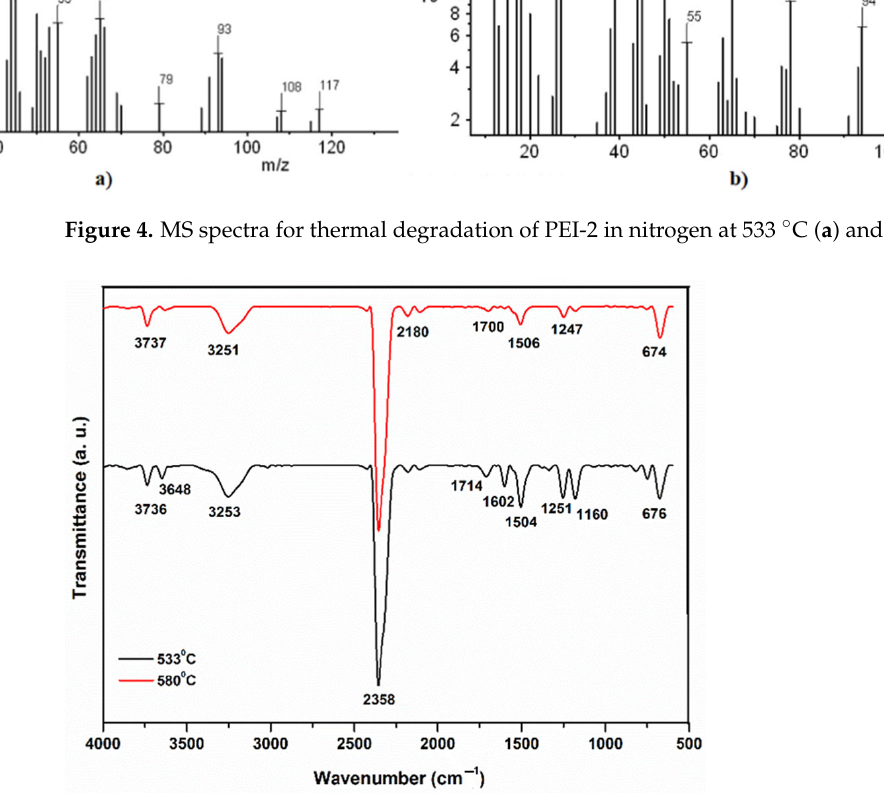
Figure 5. FTIR spectra for PEI-2 at various temperatures for thermal decomposition in nitrogen.